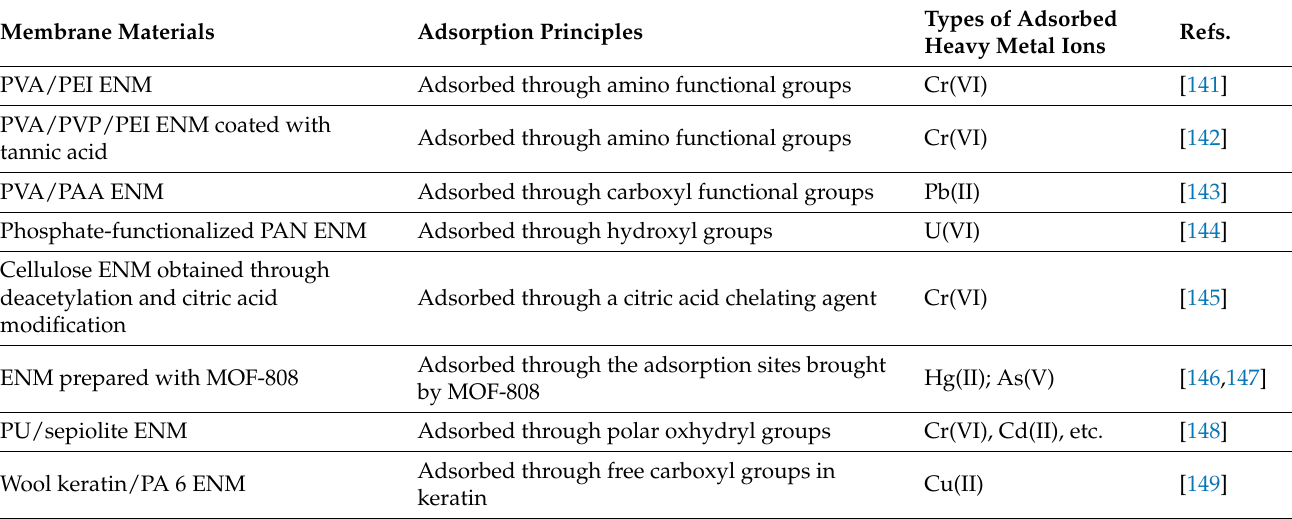
Table 3. Several studies on heavy metal ion adsorption based on